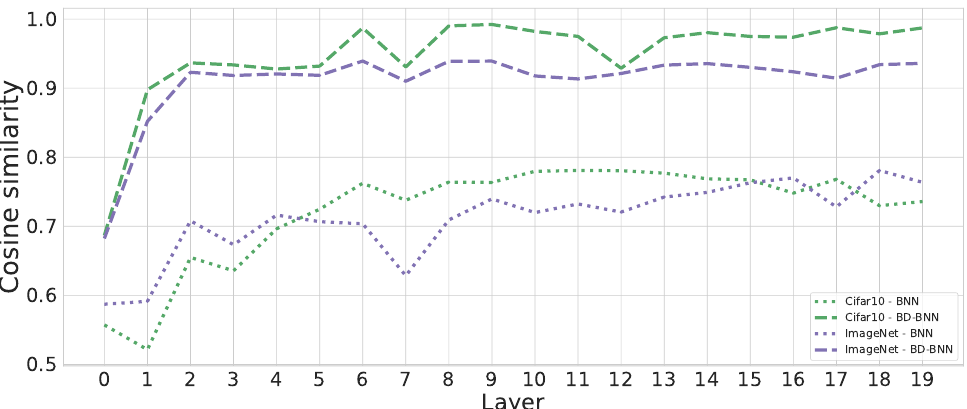
Figure 5. Cosine similarity per layer of ResNet18, trained on CIFAR10 and ImageNet datasets, dotted lines for simple trained networks, dashed for BD-BNN.